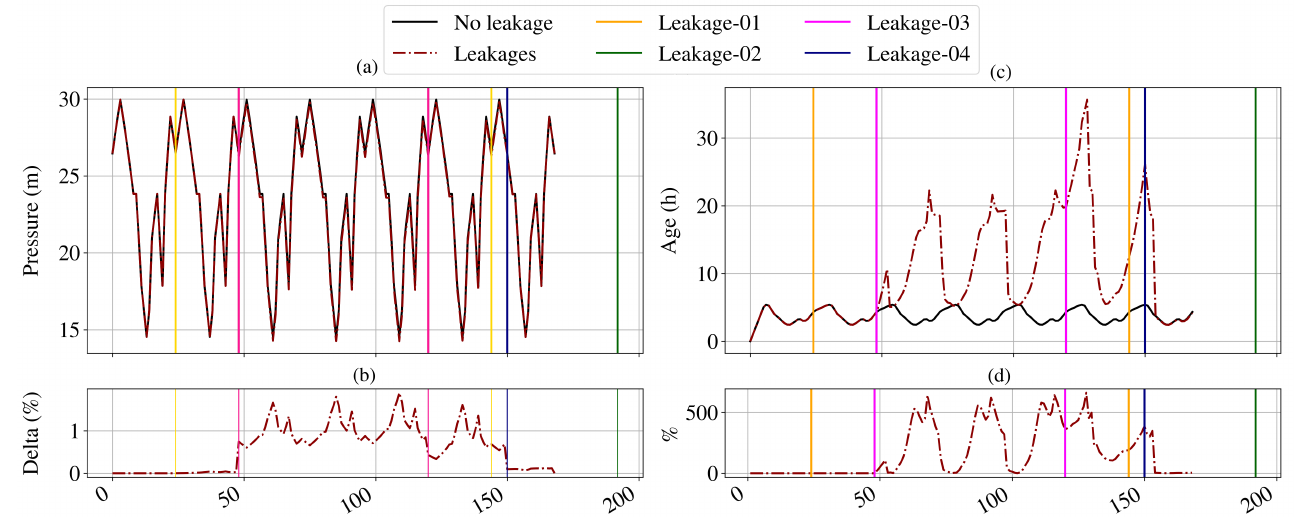
Figure 3. Node 104 - Monitoring data: ( a ) Quality variation, ( b ) Quality variation delta, ( c ) Pressure variation and ( d ) Pressure variation